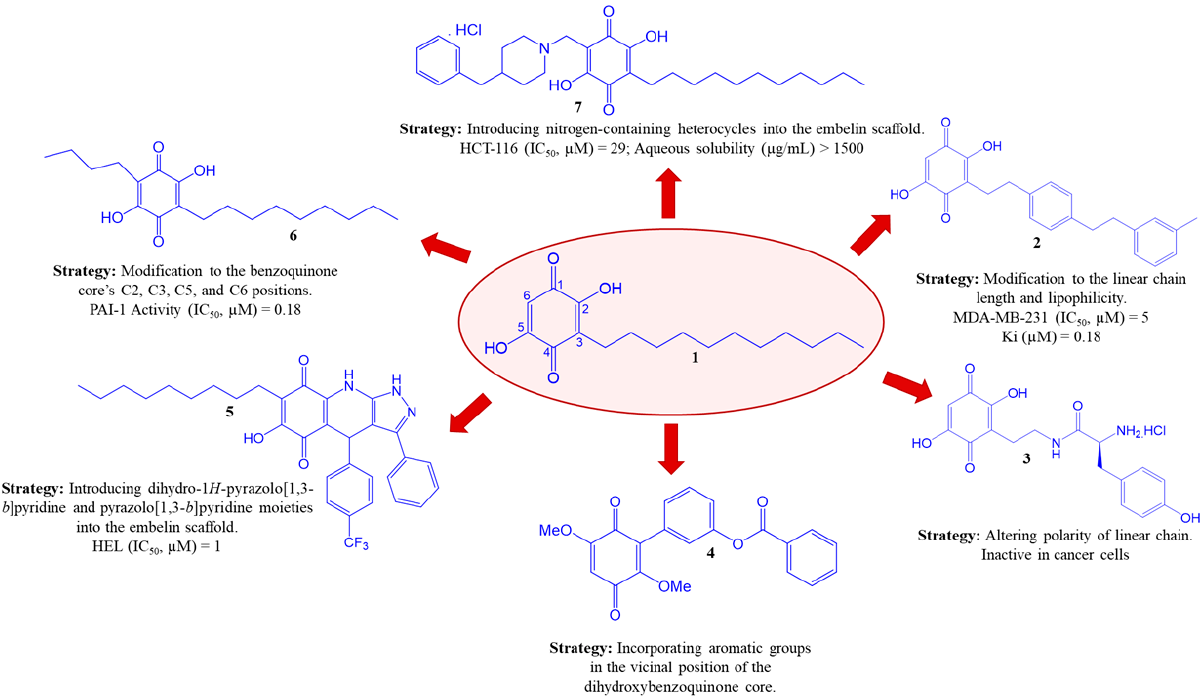
Figure 1. Chemical structure of embelin ( 1 ) and selected derivatives 2 – 7 .